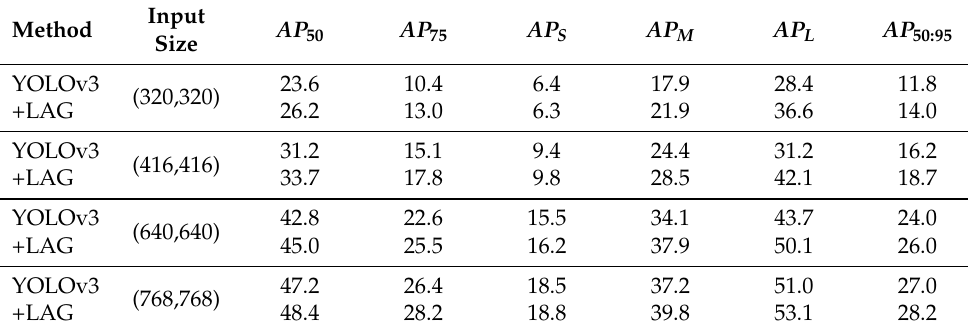
Table 2. Ablation results on different input